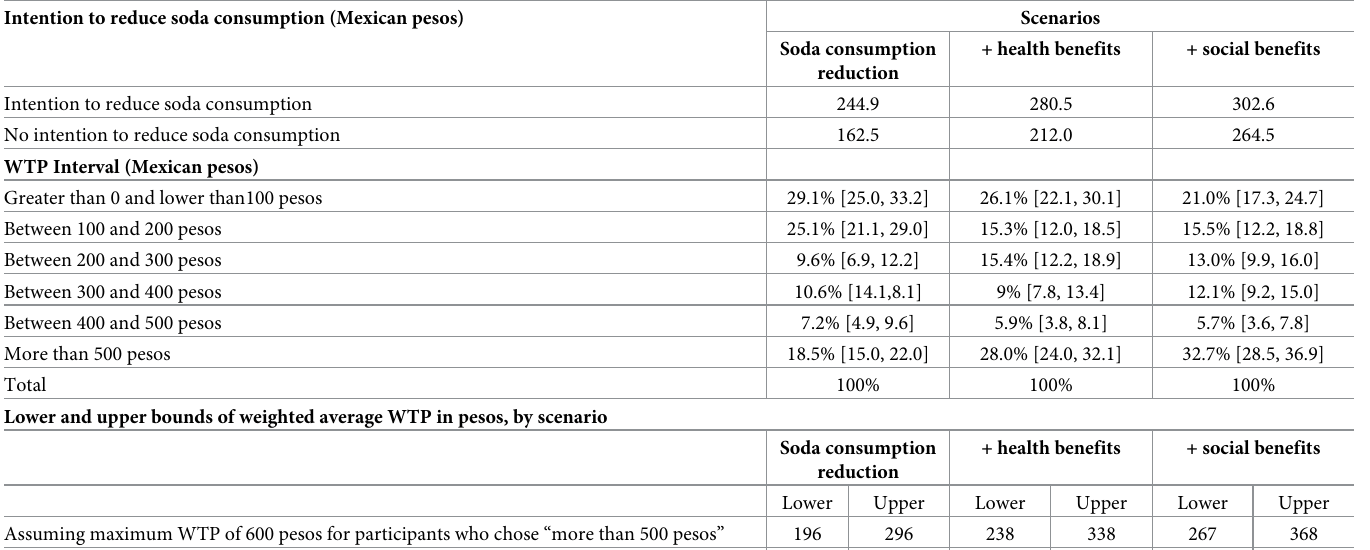
Table 2. Distribution of the sample population (n = 471) across willingness-to-pay ranges, by